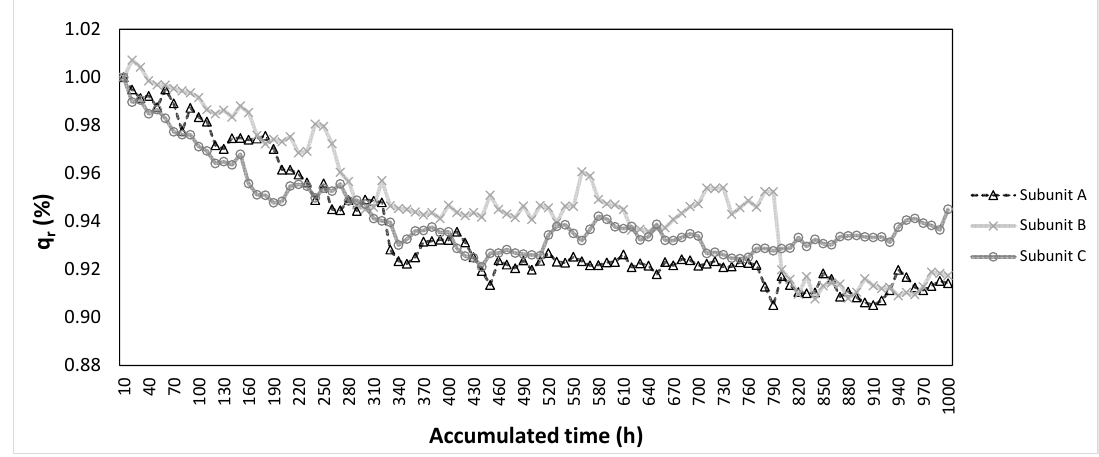
Figure 6. Average relative flow of the four water meters placed at the beginning for each irrigation subunit along the 1000 h experiment.